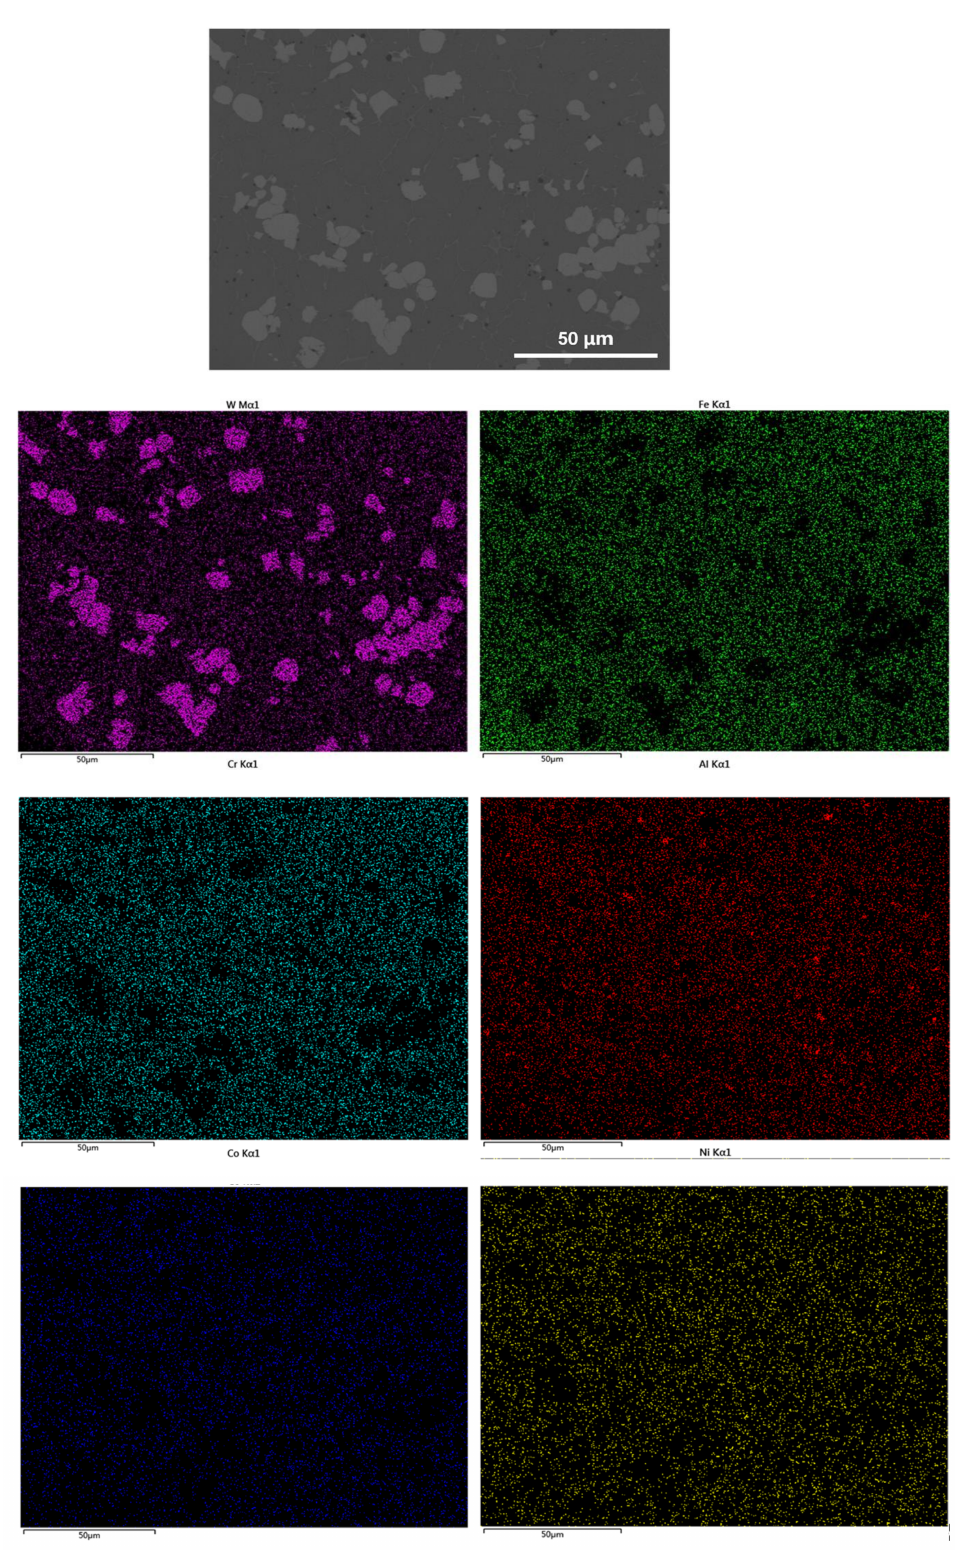
Figure 4. EDS element mapping of AlCoCrFeNiW HEA coatings on H13